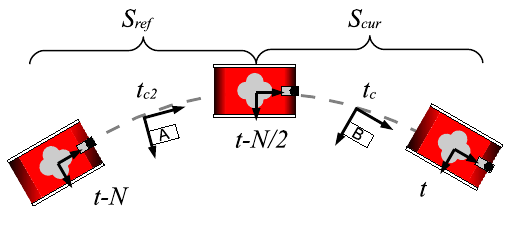
Figure 9. The scan building coordinate frames.